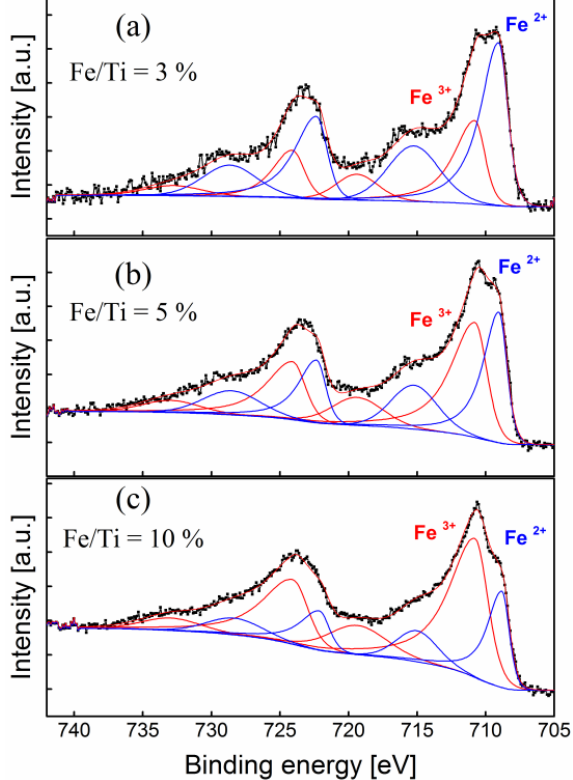
Figure 10. High resolution spectra for iron-doped samples resulting from Fe 2p peaks with an Fe/Ti ratio of ( a ) 3%, ( b ) 5%, and ( c ) 10%.